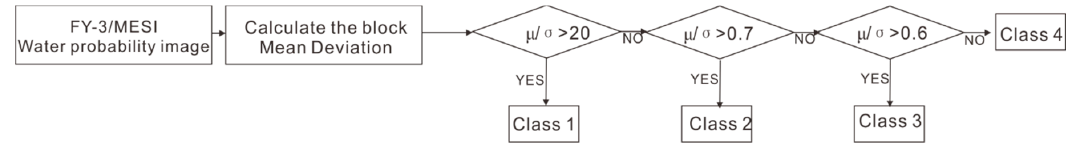
Figure 5. Rough classification flow chart of SMDPSO.